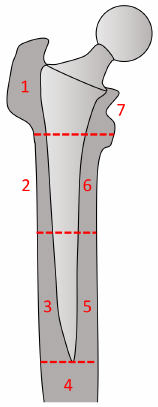
Figure 4. The Gruen zones (marked from 1 to 7) are conventionally used to identify the areas of the prosthetic system where bone remodeling has to be assessed